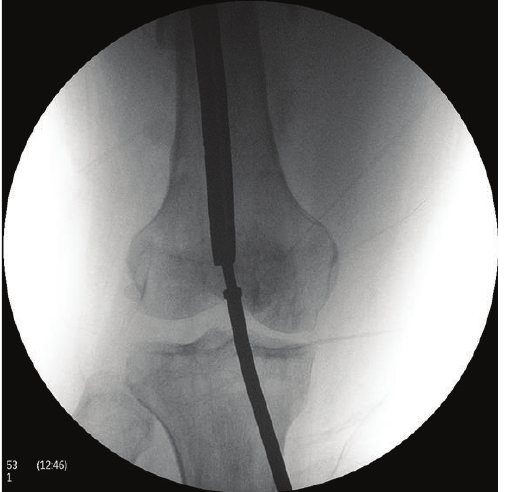
Figure 4: The picture shows application of a Harrington rod through an entry point at the intercondylar notch in order to function as an impactor for nail